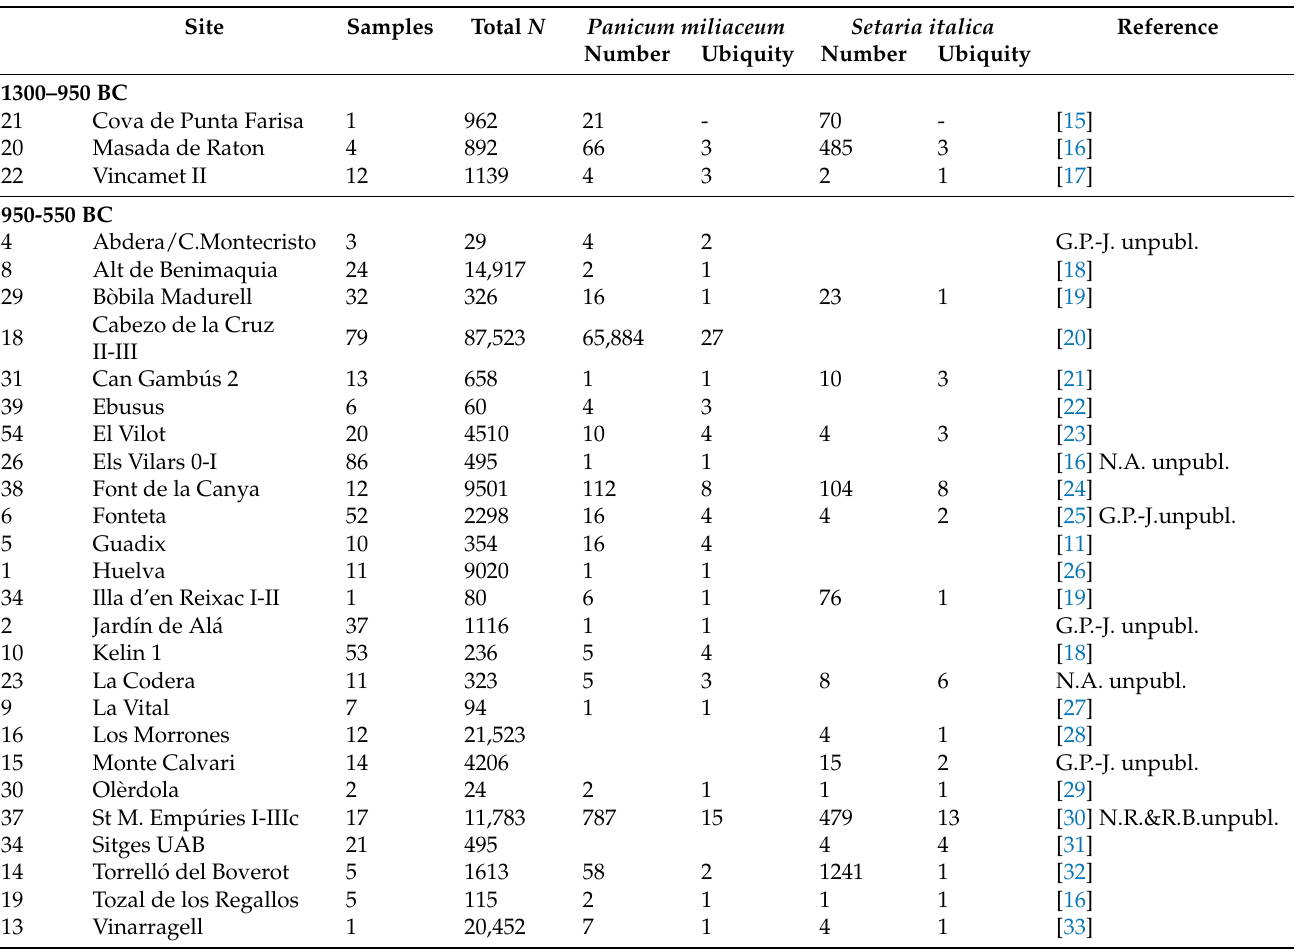
Table 1. Data related to the sites along the Mediterranean area of the Iberian Peninsula yielding remains of broomcorn and/or foxtail